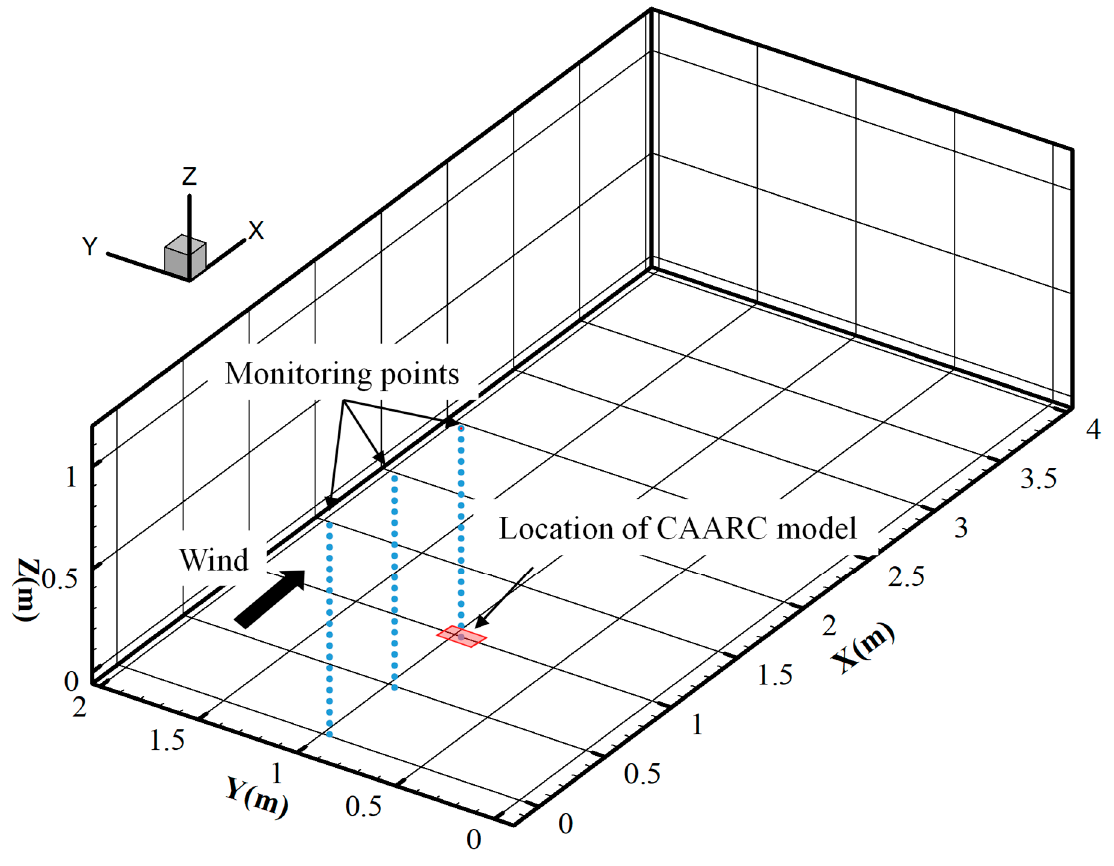
Figure 10. Location of monitoring points.